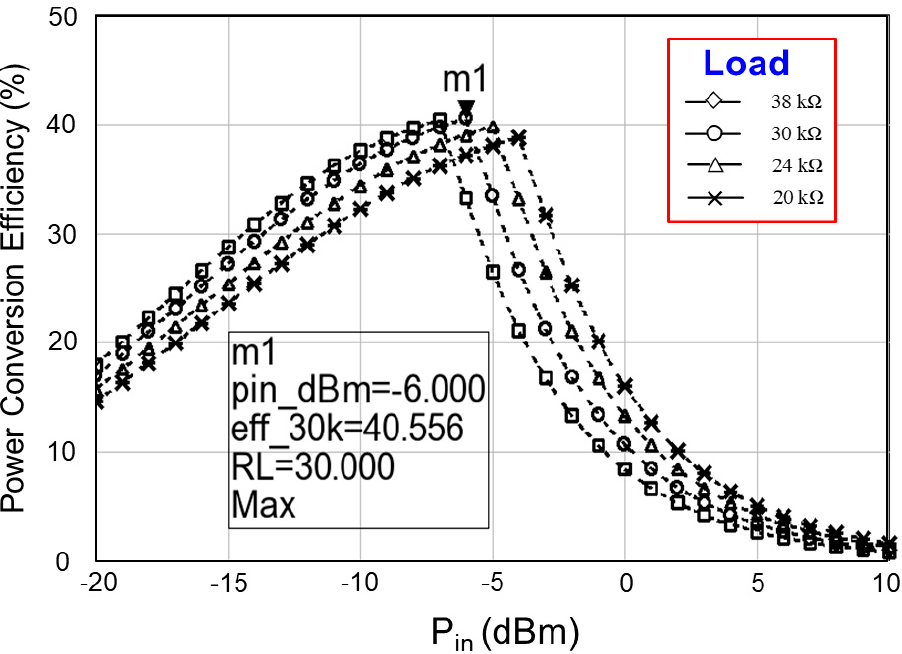
Figure 22. Measured PCE of the proposed RF-energy-harvesting IC (system PCE ) with respect to the input power (dBm) and load resistor ( Ω ).